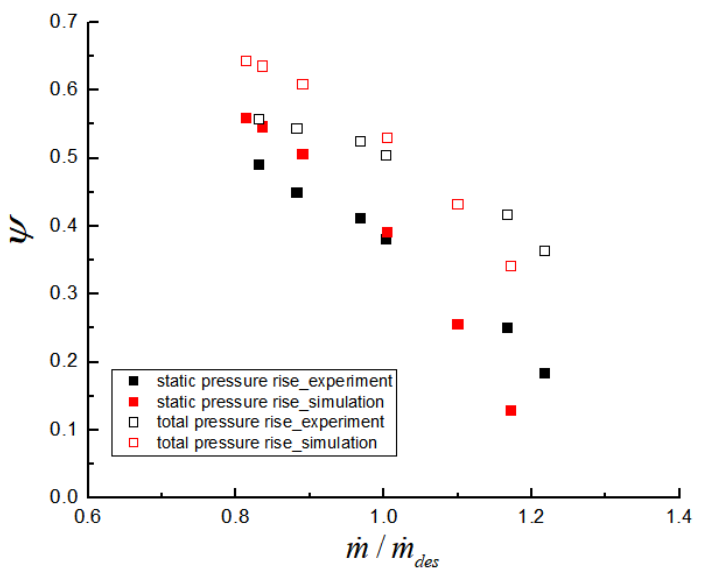
Figure 5. Comparison of numerical and experimental results at 3000 rpm.